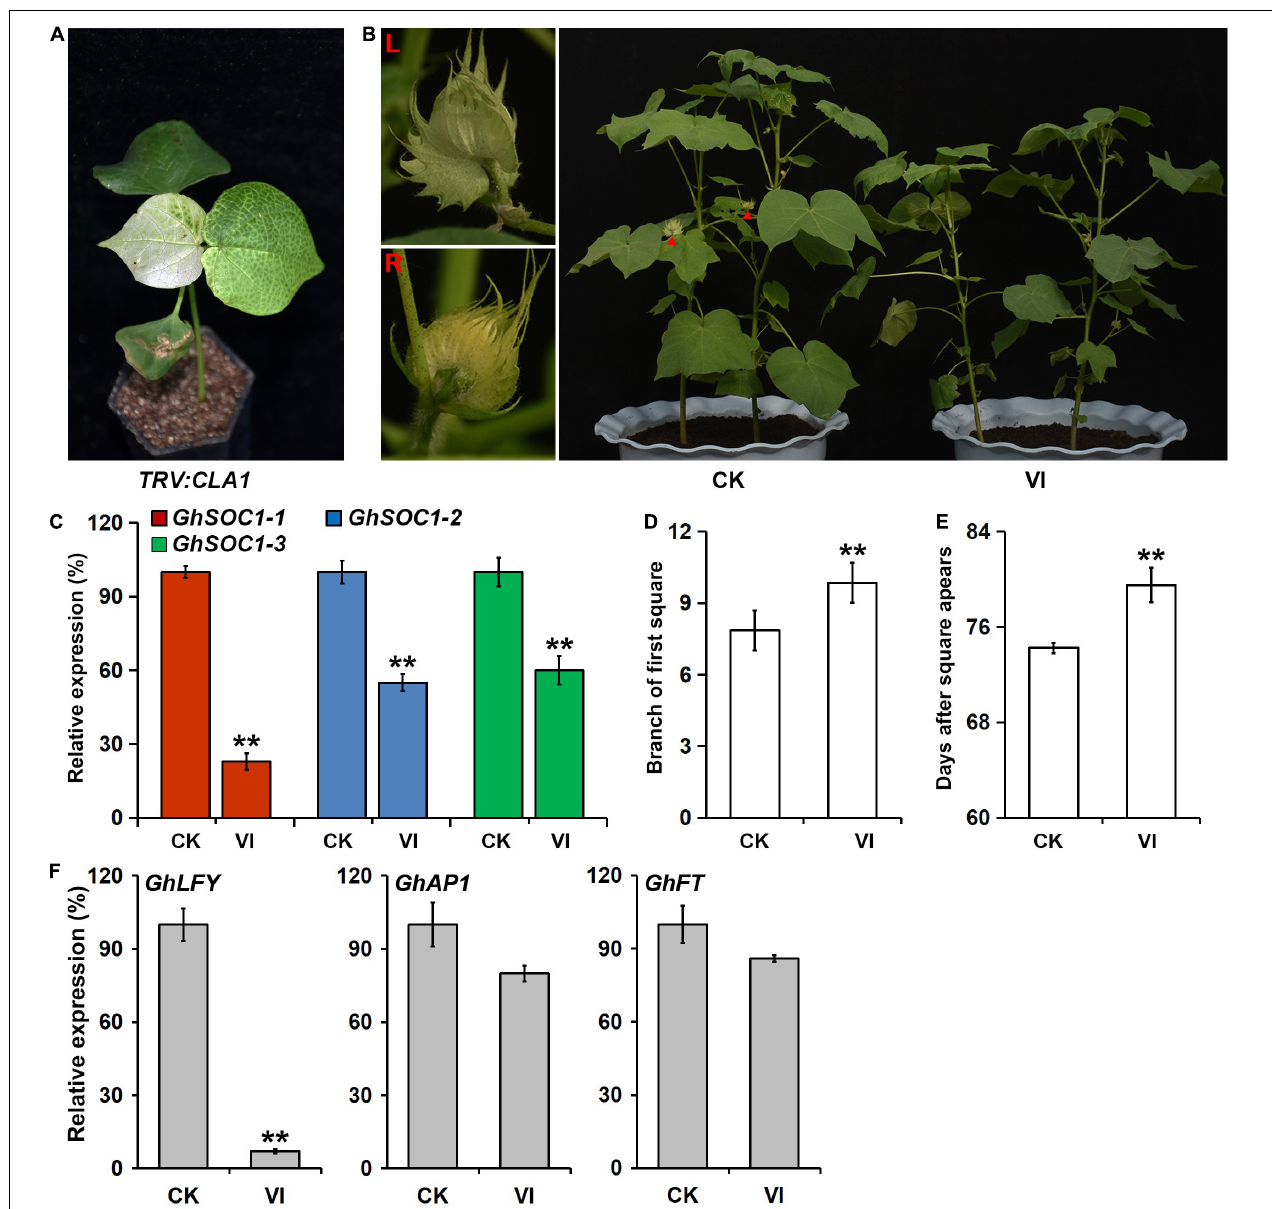
FIGURE 6 | VIGS of GhSOC1s in G. hirsutum delays flowering time. (A) Albino phenotype of TRV:CLA1 as a control. (B) Delayed flowering phenotype of VIGS plants. Red triangles point the flower buds displayed in the left. CK, empty vector control; VI, silence plants. (C) Detection of the efficiency of gene silencing. The expression was normalized to GhHIS and the maximum expression is set as 100%. Error bars represent the standard deviations of three biological replicates. (D,E) Maturity traits of VIGS plants in branch of first square (D) and days from sowing until square appears (E) . Asterisks indicate statistically significant differences among 15 individuals according to Student’s t -test (** P < 0.01). (F) Expression of GhLFY , GhAP1, and GhFT in Silencing and control plants. The expression is normalized to GhHIS and the maximum expression is set as 100%. Error bars represent the standard deviations of three biological